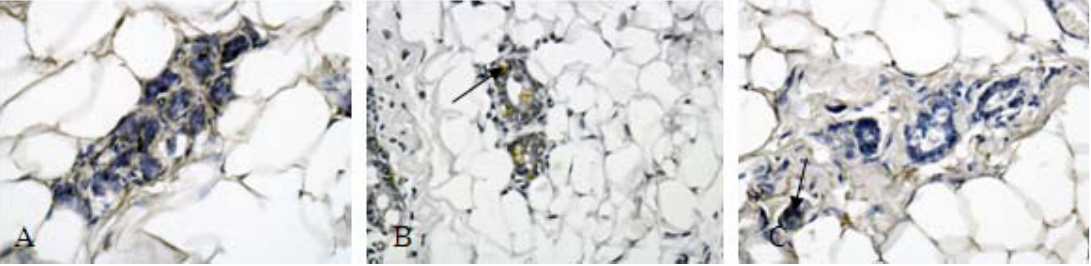
Figure 4. Immunohistochemical analysis of annexin A1 expression in rat besast tissue. (Magni fi cation ×400; A, normal control group; B, model group; C, RuXian-I group). The arrows indicate the target proteins stained in brown-yellow. Statistically, positive expression rates of annexin A1 were signi fi cantly correlated with breast hyperplasia. After treatment RuXian-I, annexin A1 expression decreased. The arrow in C shows negative immunoreactivity of RuXian-I